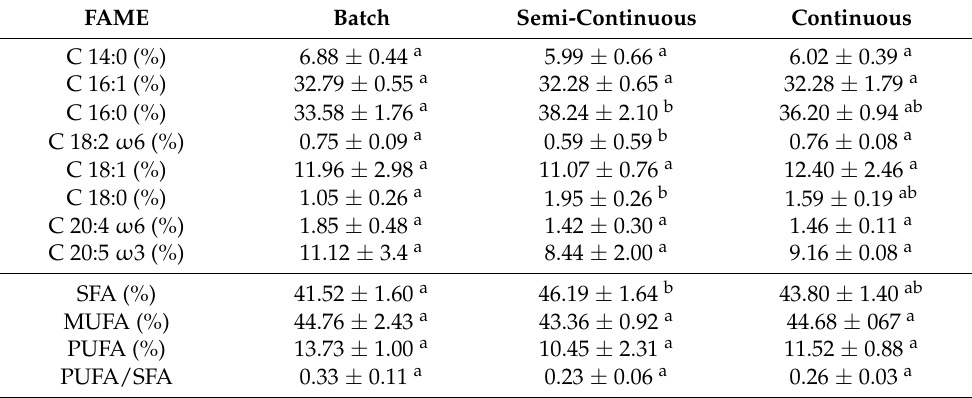
Table 5. Fatty acid methyl esters (FAME) content and profile, presented in percentage of total FAME and saturation distribution of the FAME profile in three different operation regimes of Nannochloropsis oceanica grown in 2.6 m 3 outdoor tubular PBR. The values represent the average and standard deviation of two biologically independent replicates and two analytical replicates. Different letters within the same row represent significantly different values ( p -value < 0.05). FAME Batch Semi-Continuous Continuous